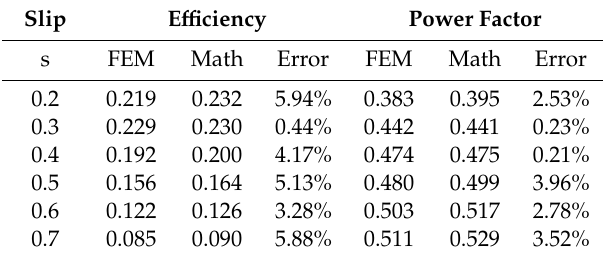
Table 6. E ffi ciency and power